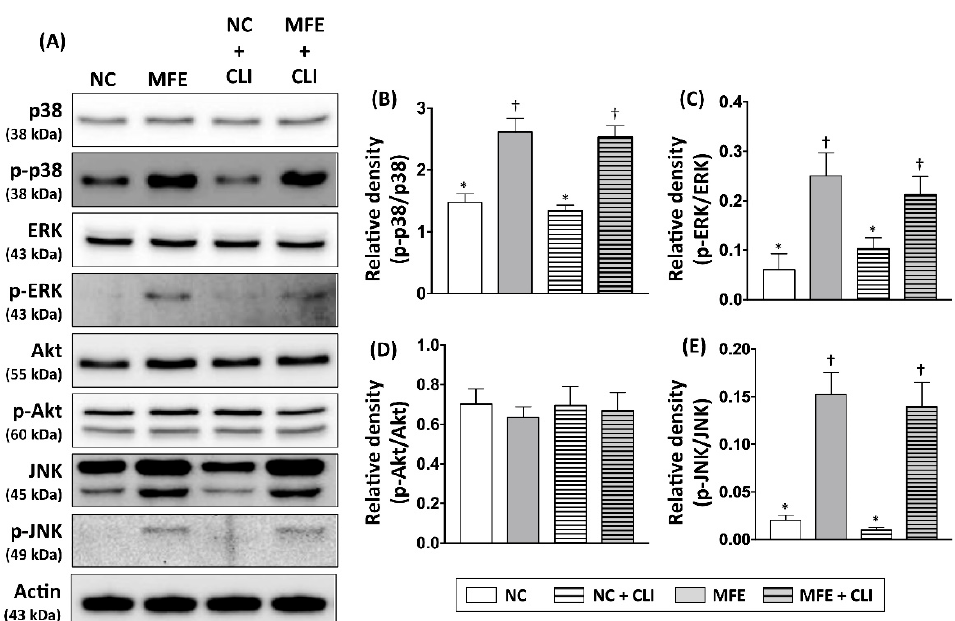
Figure 6. Maternal fructose exposure regulated expression and phosphorylation levels of angiogenesis-associated signaling in bone marrow cells. ( A ) Western blots to detect the expression and phosphorylation levels of several intracellular signaling proteins, including Akt, ERK1 / 2, p38-MAPK, and JNK in peripheral mononuclear cells (PBMC) of offspring 14 days post induction of CLI. ( B ) Quantitative data represent the ratio of phosphorylated p38-MAPK expression to total p38-MAPK expression. ( C ) Quantitative data represent the ratio of phosphorylated ERK1/2 expression to total ERK1/2 expression. ( D ) Quantitative data represent the ratio of phosphorylated Akt expression to total Akt expression. ( E ) Quantitative data represent the ratio of phosphorylated JNK expression to total JNK expression. NC, normal control; MFE, maternal fructose exposure; CLI, critical limb ischemia. Error bars represent the standard deviation (SD). Groups with different symbols (*, †), p < 0.05. n = 8 for each group.